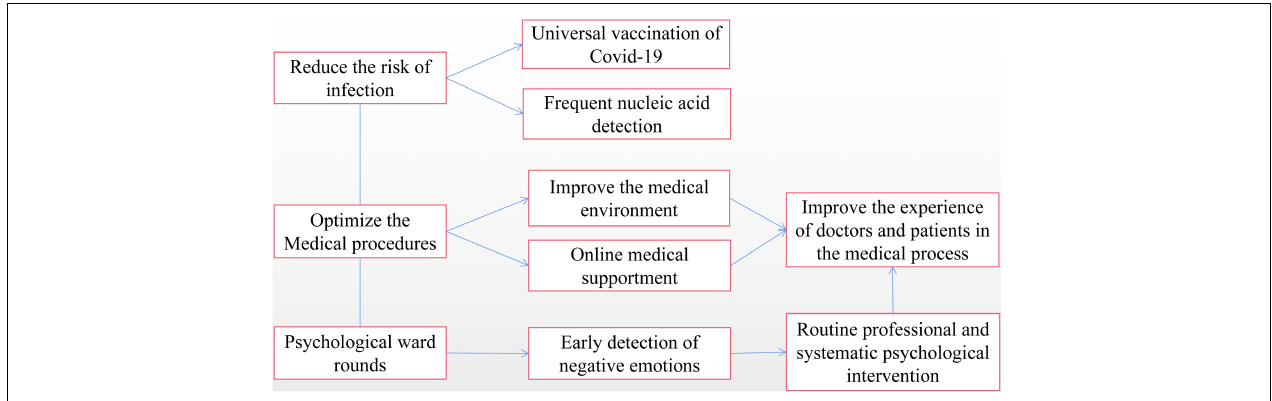
FIGURE 2 | Psychological analysis and countermeasures of general hospital management and patients’ psychologic status during the post-pandemic “Normalized pandemic prevention”